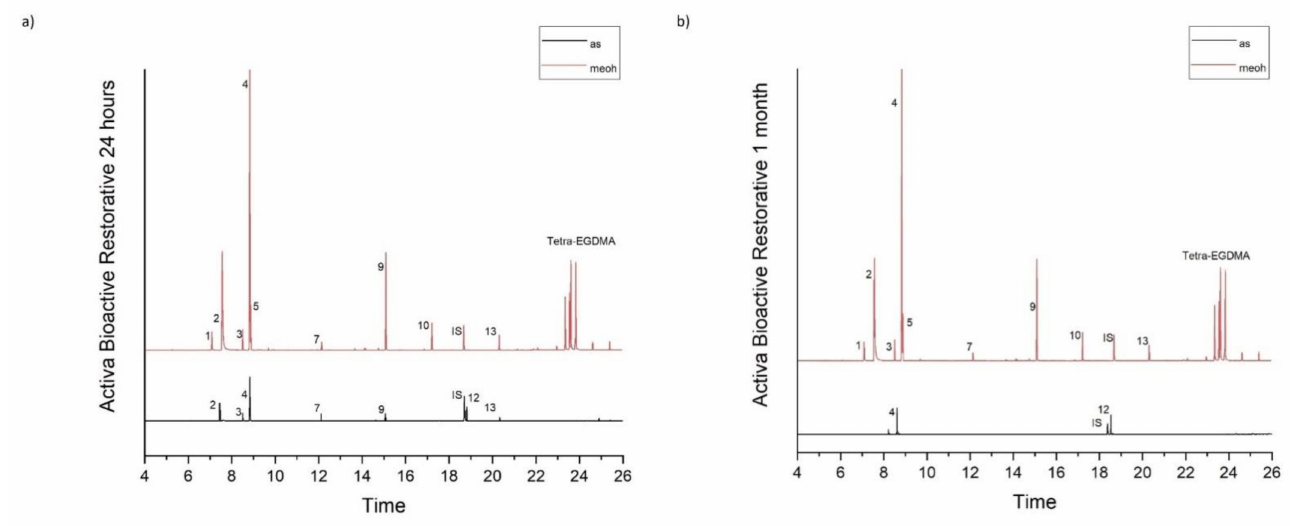
Figure 1. ( a , b ). Chromatograms of Activa Bioactive Restorative in artificial saliva and methanol for both observation periods (24 h and 1 month).